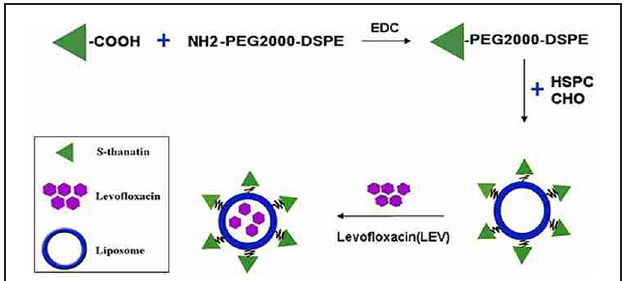
FIGURE 1 | Schematic representation of the preparation of